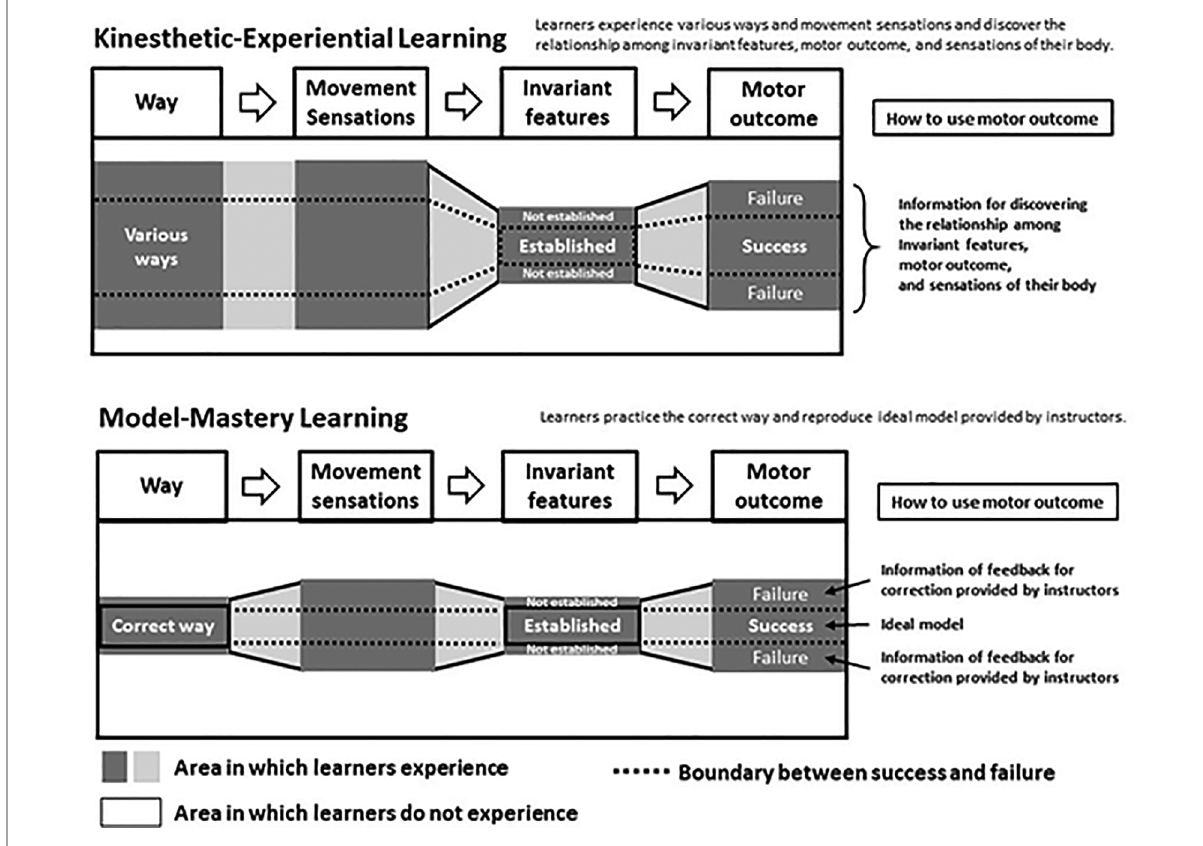
FIGURE 1 Conceptual diagram of kinesthetic-experiential learning and model-mastery learning methods (Matsuura et al., 2022). Speci fi c details are shown in Tables 1 , 2